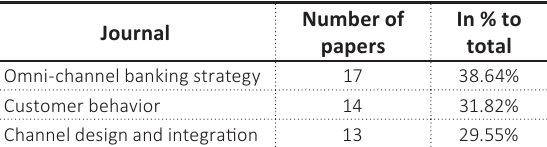
Table 5. Distribution of omni-channel management papers by